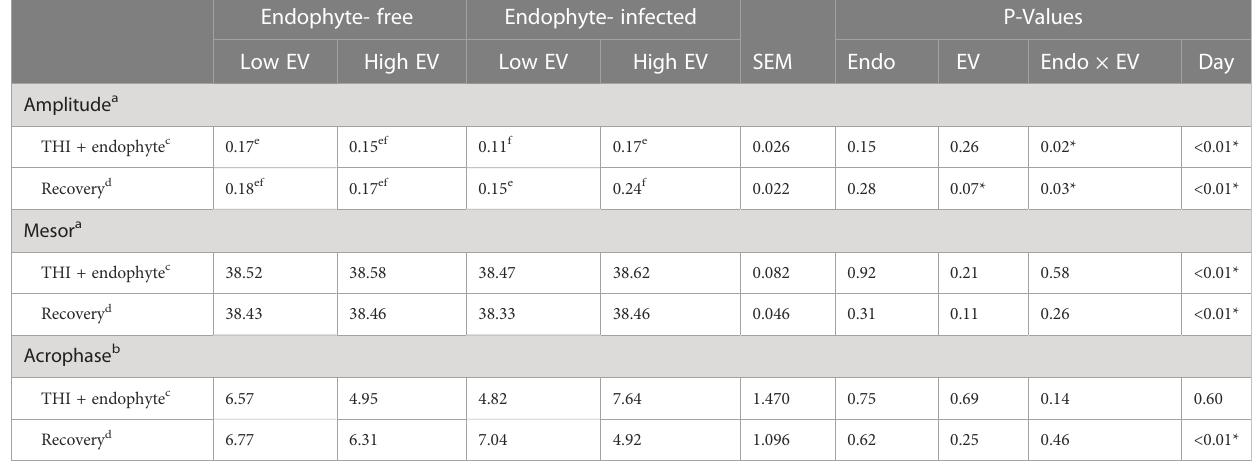
TABLE 5 Experiment 2 ruminal temperature responses to endophyte (Endo) and exit velocity (EV)